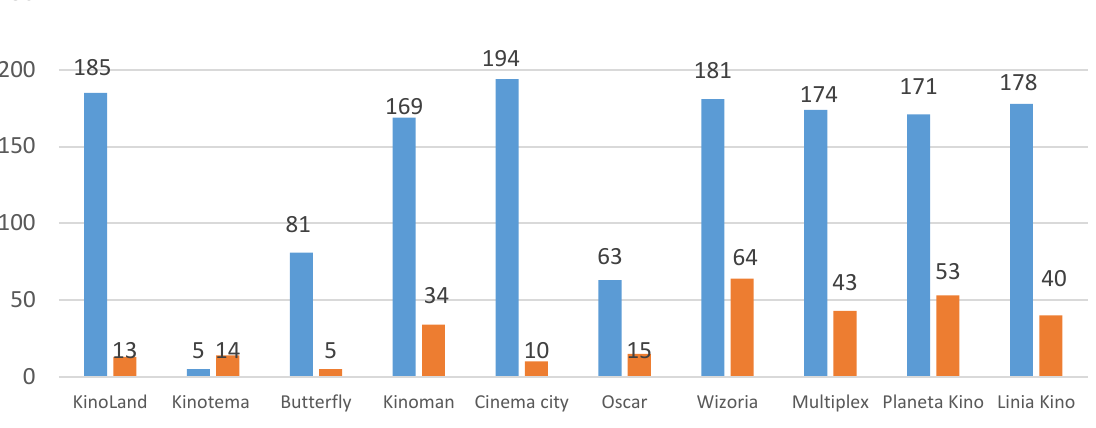
Source: Developed by the authors.